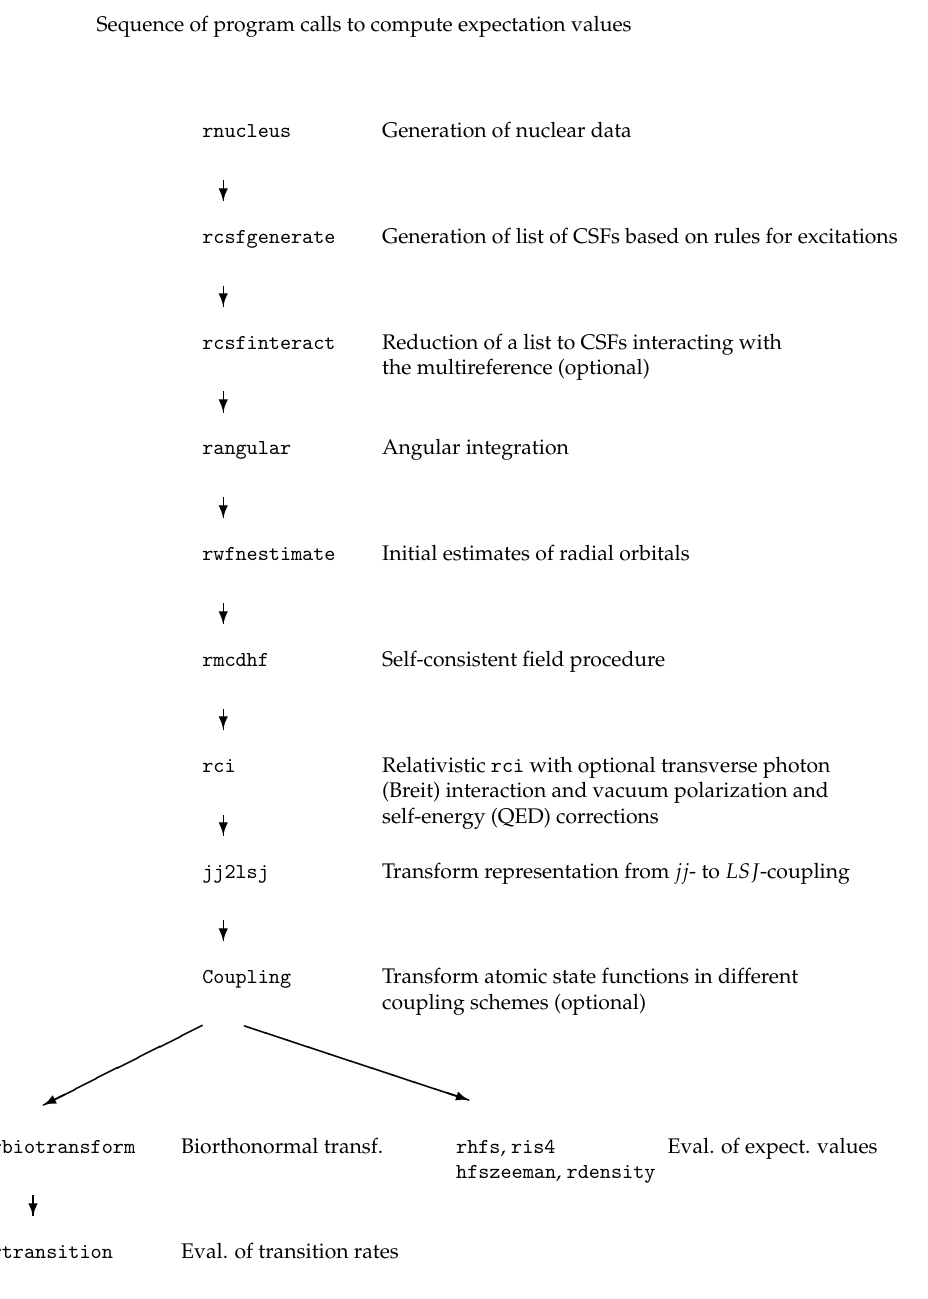
Figure 1. Typical sequence of program calls to compute expectation values and transition rates and to obtain labels in different coupling